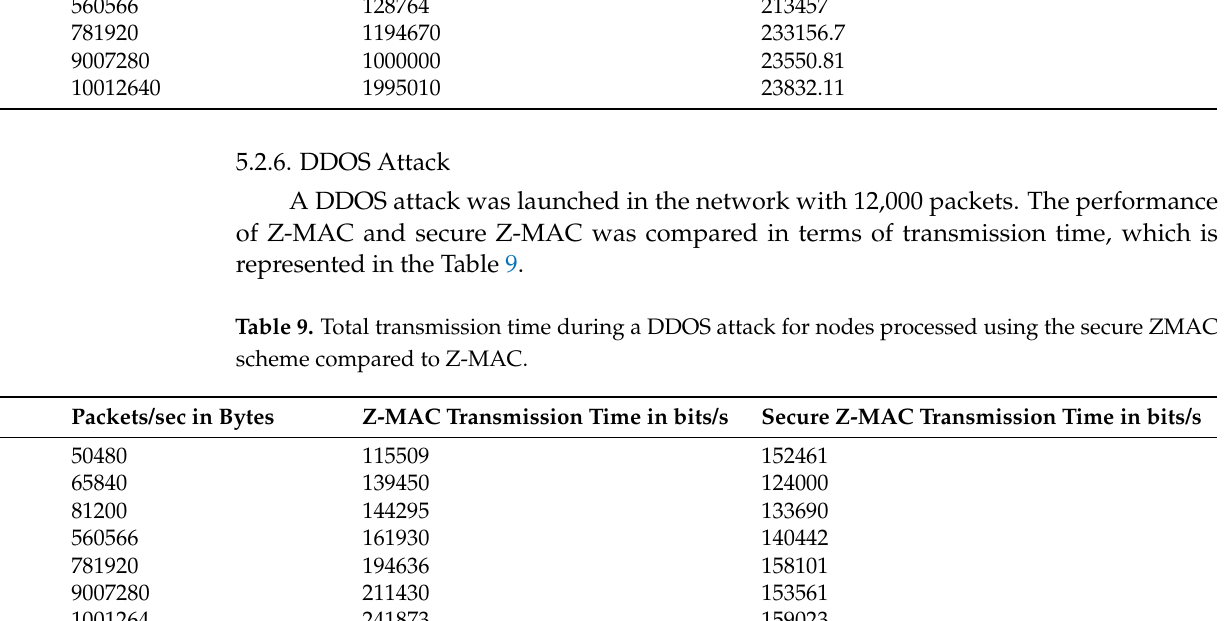
Table 9. Total transmission time during a DDOS attack for nodes processed using the secure ZMAC scheme compared to Z-MAC.